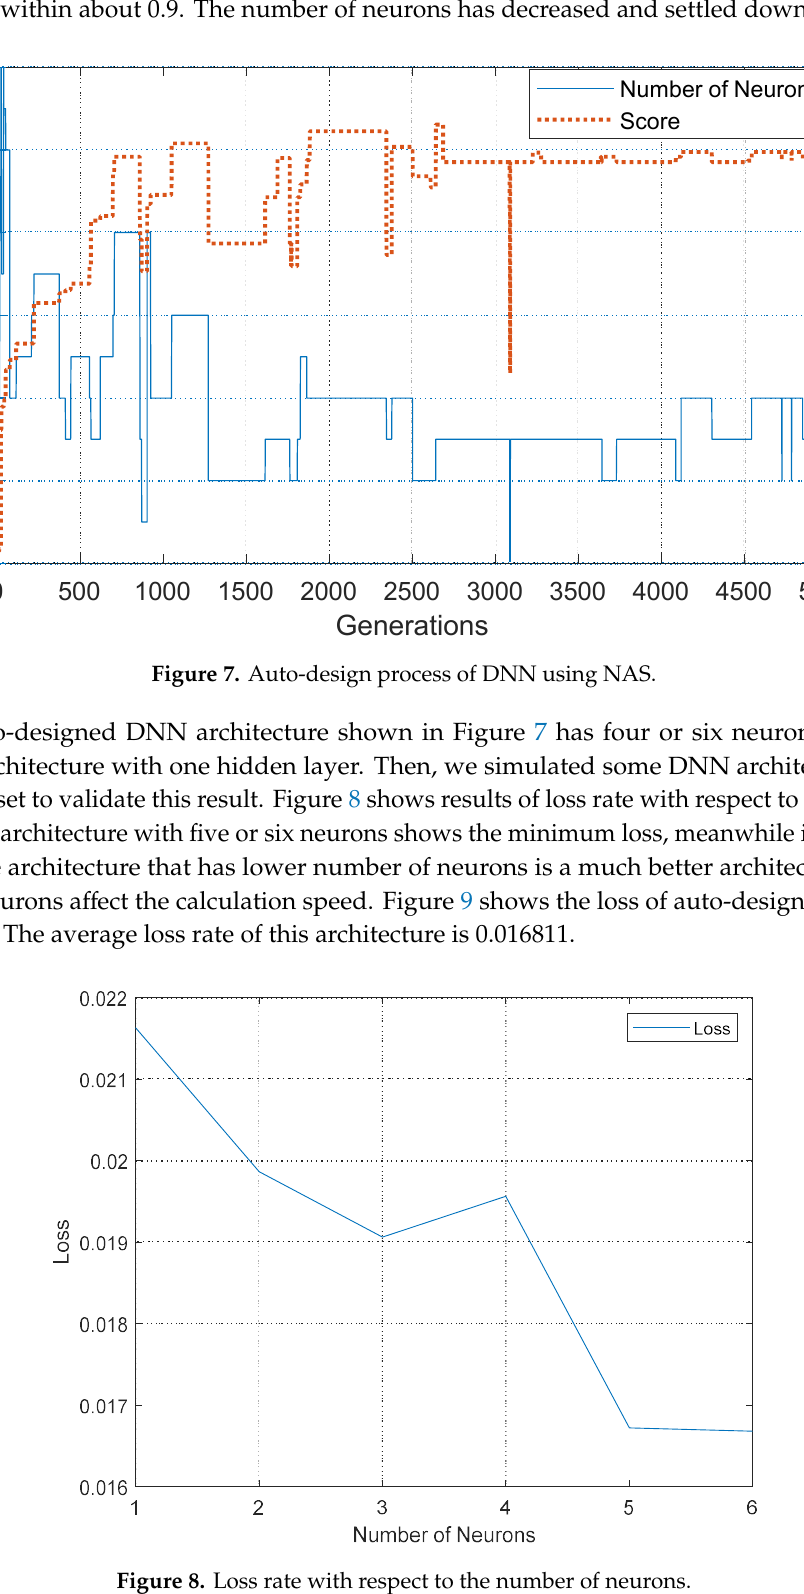
Figure 8. Loss rate with respect to the number of neurons